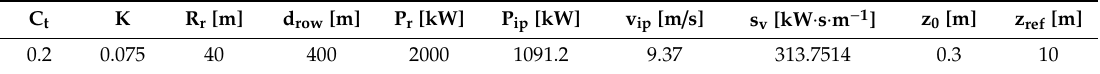
Table 1. Parameters of the simulation cases.